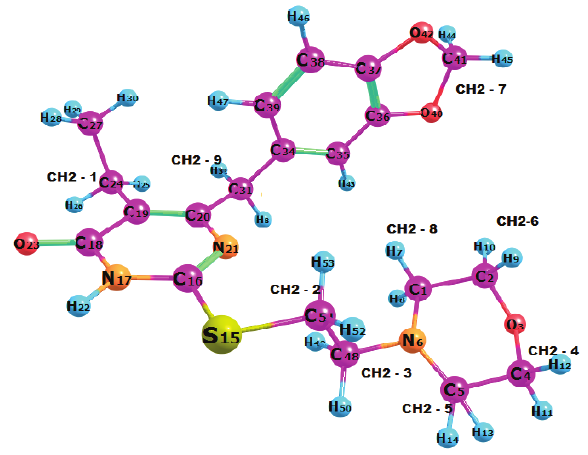
Figure 1: The optimized molecular structure of the title molecule based on the B3LYP/6-311++G(d,p) level of basis set.